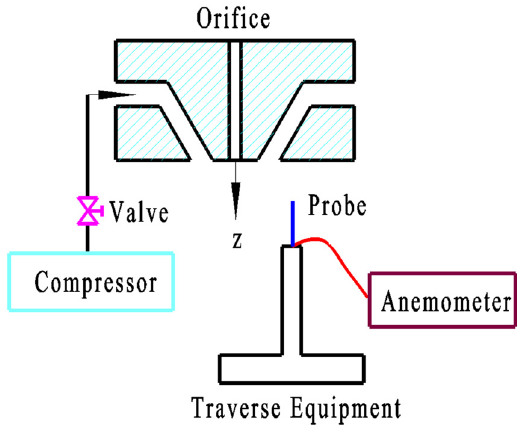
Figure 2: The experiment